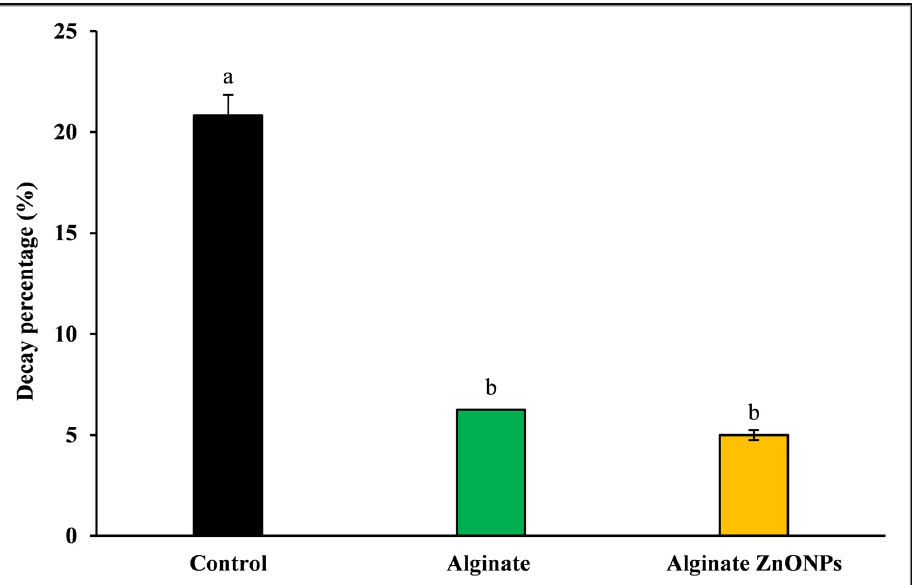
Figure 16. Effect of Alg–ZnO NPs on decay percentage of “Kiett” mango fruits during shelf life period; vertical bars represent the standard error (SE). Bars marked with the same letter are not significantly different with 95% confidence according to Duncan’s multiple range test.